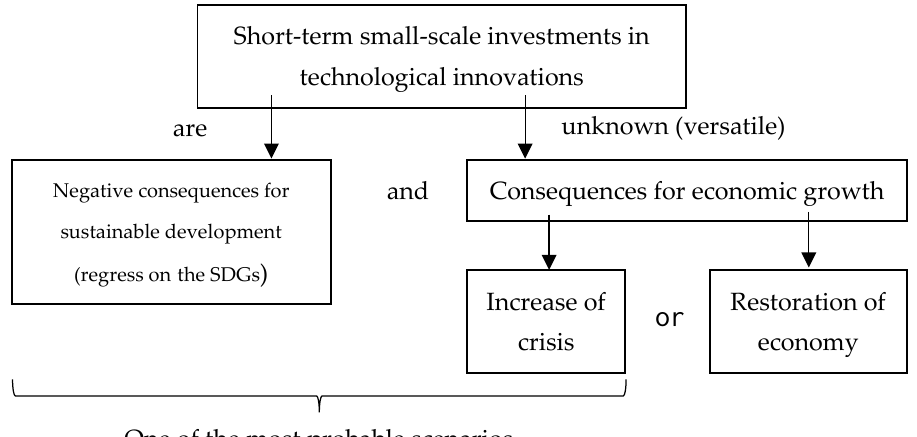
Figure 1. The consequences of investments according to the existing approach to financial risk management amid the economic crisis. Source: authors.